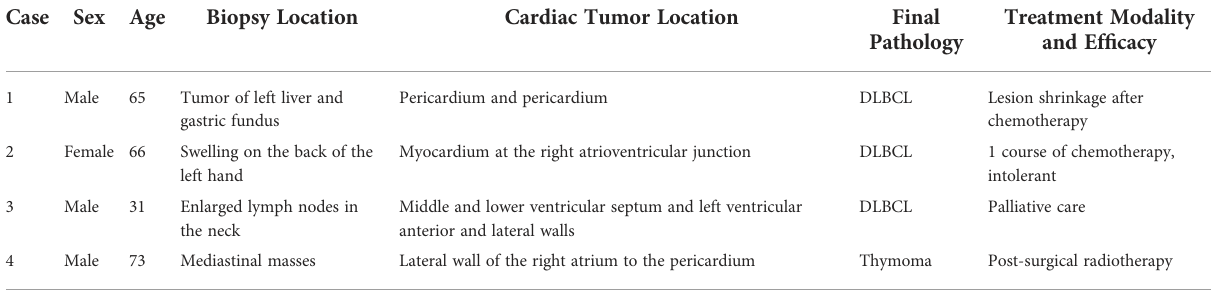
TABLE 2 Patient data for PUS-CNB of extracardiac lesions.